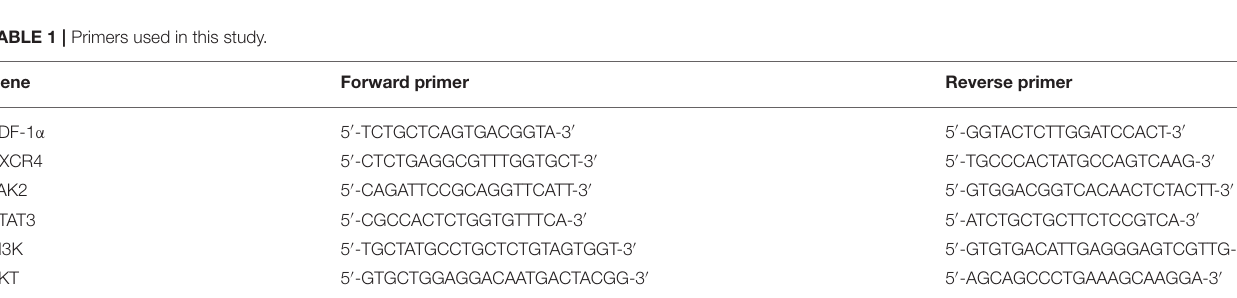
TABLE 1 | Primers used in this